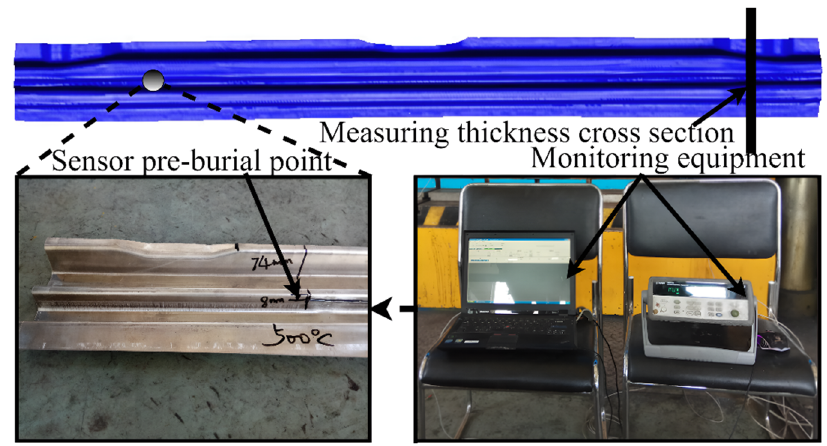
Figure 6. The experimental program.